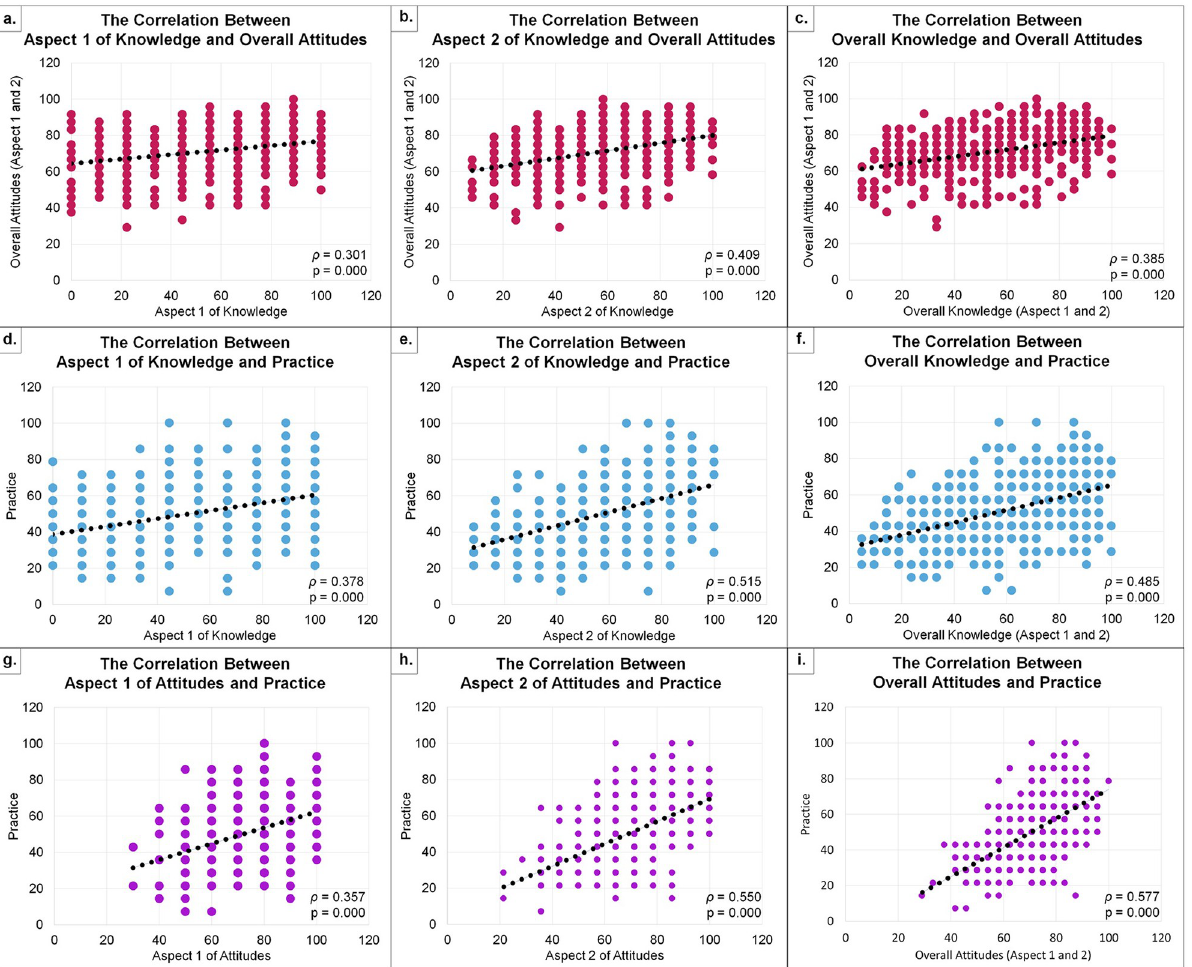
Fig 1. Correlation between knowledge, attitude, and practice towards HPV, CC, and HPV vaccination. Aspect 1 is about understanding the HPV virus and CC, while aspect 2 is related to HPV vaccination. Rho-value ( ρ ) 0.2–0.4 is considered as weak positive correlation (charts a, c, d, and g); and 0.4–0.6 is considered as moderate positive correlation (charts b, e, f, h, and i). All statistical analysis using Spearman’s test. Normality test with Kolmogorov-Smirnov for aspects 1 and 2 of knowledge, overall knowledge, aspect 1 and 2 of attitude, overall attitude, and overall practice score were 0.000. The data is afterward assumed to be abnormal in the distribution in distribution (indicating substantially skewed distribution).